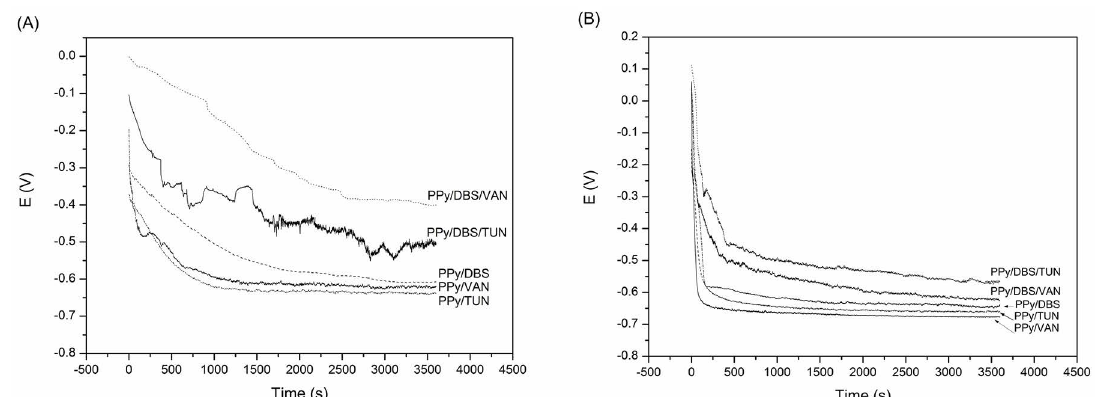
Figure 3. The corrosion potential (ECORR) as a function of the immersion time in (A) 0.05 mol L -1 NaCl and (B) 0.05 mol L -1 HCl solutions of the AA 1100 coated with PPy